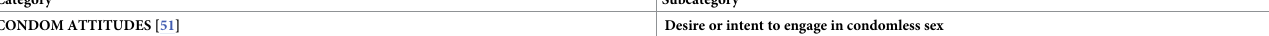
Table 1. Overview of final coding framework and categorisation system with definitions (categories and subcategories listed in alphabetical order).